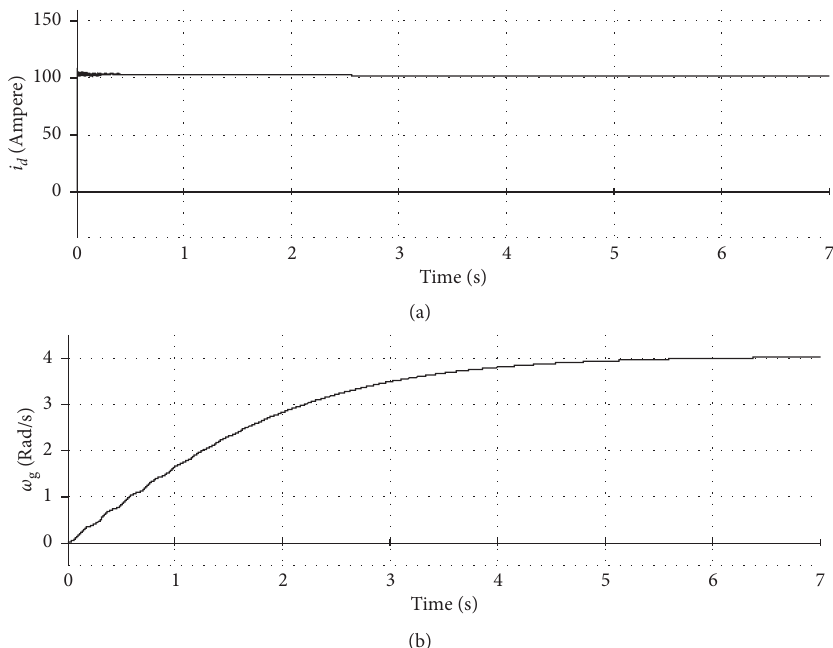
33 and its respective quasi-steady state response